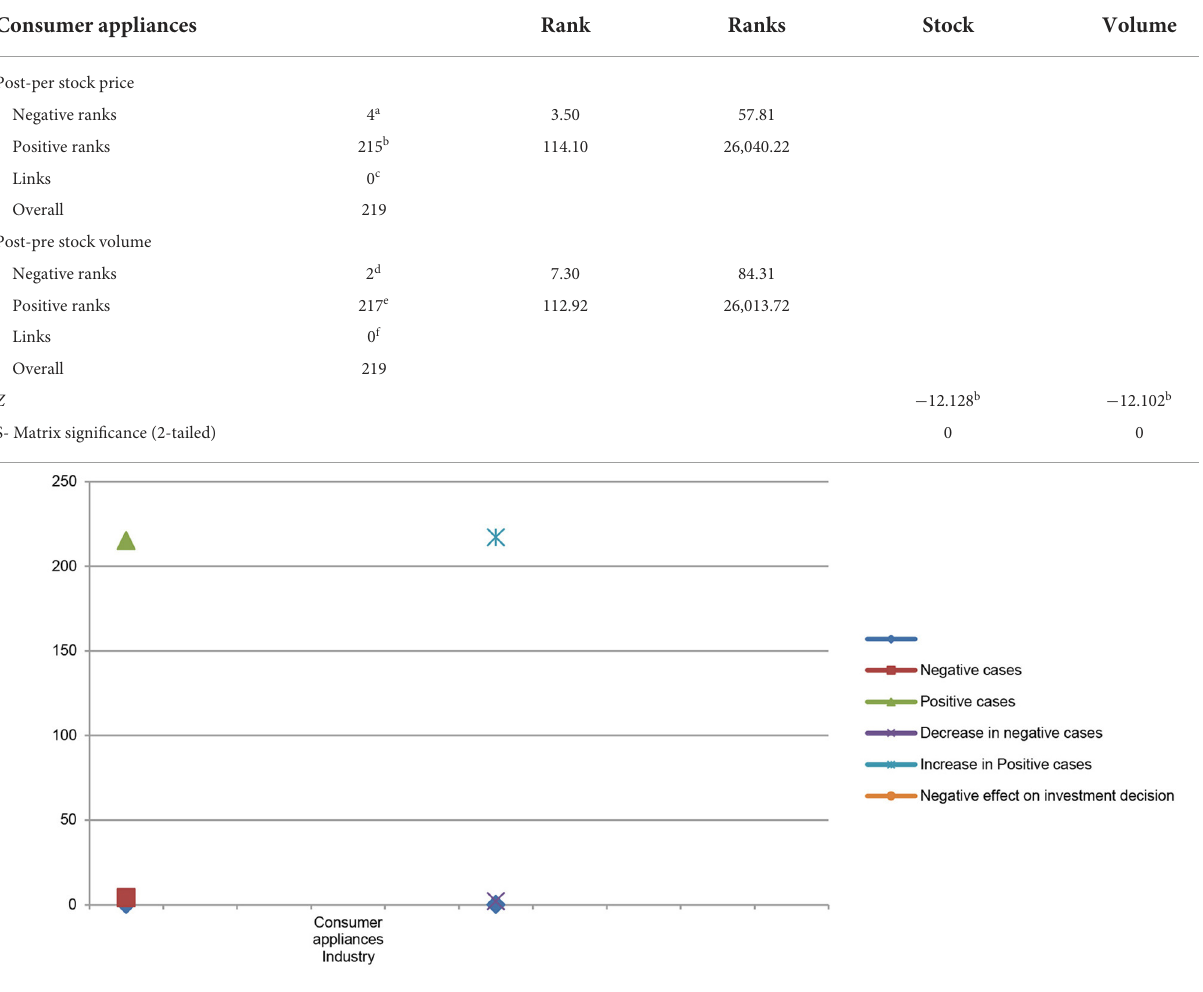
TABLE 4 Multiple regression of the consumer appliances